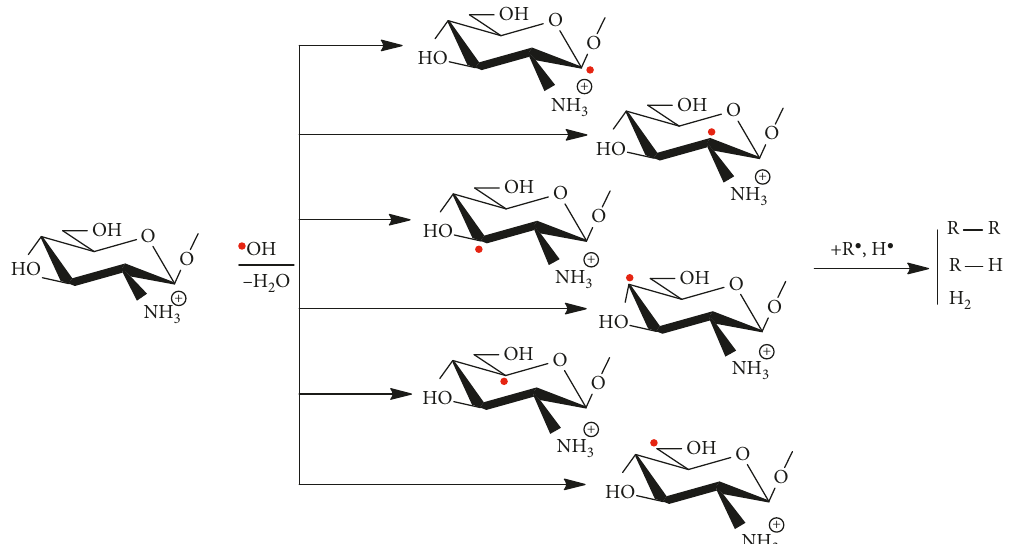
Figure 1: The mechanism of abstraction of hydrogen by hydroxyl radical [21] in the degradation of chitosan.